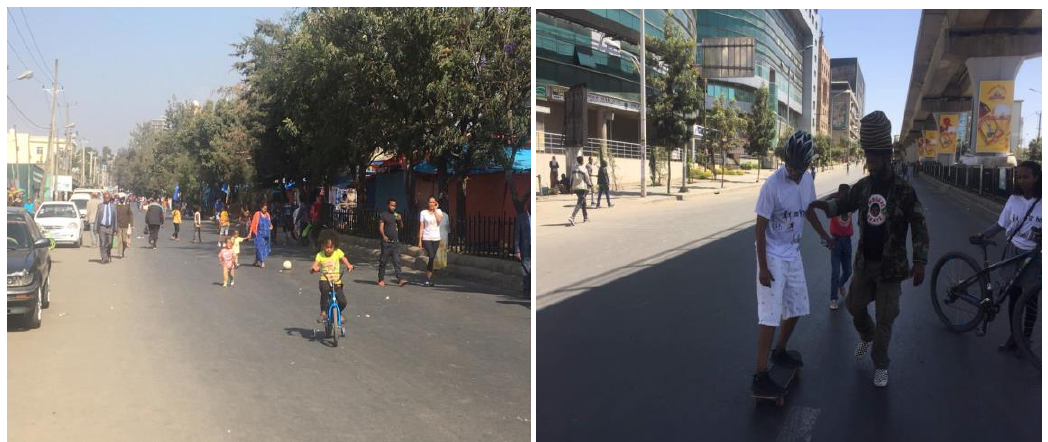
Source: Photo: From Traffic Management